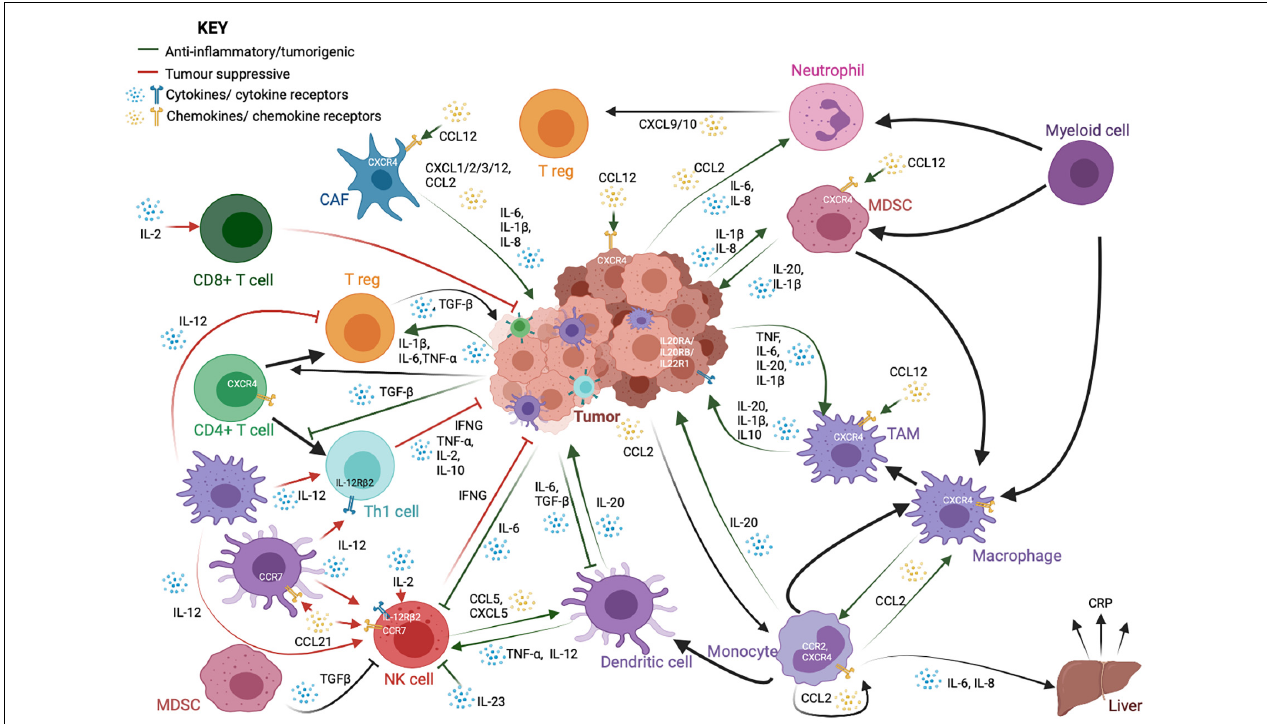
FIGURE 1 | A schematic showing the complex interactions between cancer cells and immune cells, particularly those in the tumor microenvironment. While immune cells, such as cytotoxic CD8 + T-cells, T helper (Th1) and natural killer (NK) cells, are important for anti-tumor responses and cancer cell clearance, tumors and cancer-associated fibroblasts (CAFs) often employ a variety of signaling molecules that result in the dysregulation of a variety of both lymphoid and myeloid-derived immune cells. The crosstalk between these cells further dampens the anti-tumor response and exacerbates oncogenic phenotypes such as cancer cell proliferation and metastasis. This signaling network is reliant upon a whole host of cytokine and chemokine ligands and their receptors. These cytokines and chemokines could also be present in the tumor microenvironment as a result of chronic inflammation, and release from the tumor and infiltrating tumor cells could lead to persistent inflammation in turn. The factors shown here are only a part of the many factors involved in cell-to-cell crosstalk. They have been highlighted here because their expression is regulated by